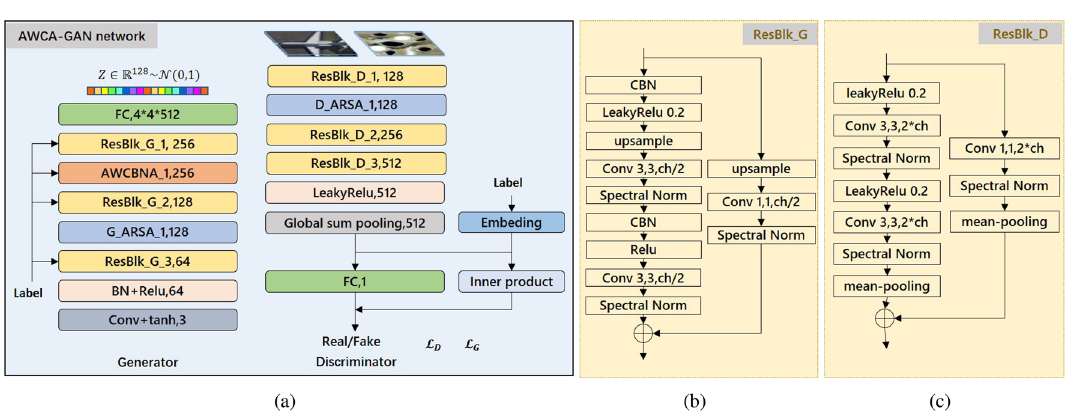
Figure 2. Structure details of AWCA-GAN. ( a ) The architecture of AWCA-GAN. ( b ) Residual block of the generator (ResBlk_G) in AWCA-GAN. ( c ) Residual block of the discriminator (ResBlk_D) in